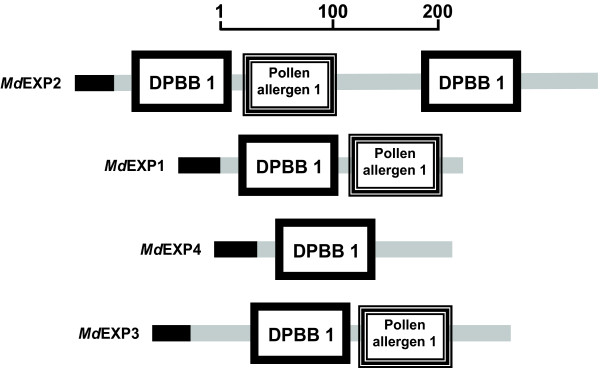
Schematic representation of the domains with significant E-value in the Micrasterias denticulata expansin-resembling proteins MdEXP2, MdEXP1, MdEXP4, and MdEXP3. The black line indicates the signal peptide. DPBB1, a rare lipoprotein A-like double-psi beta-barrel domain. The pollen allergen 1 domain is similar to expansin domain 2. Scale gives length in amino acids.